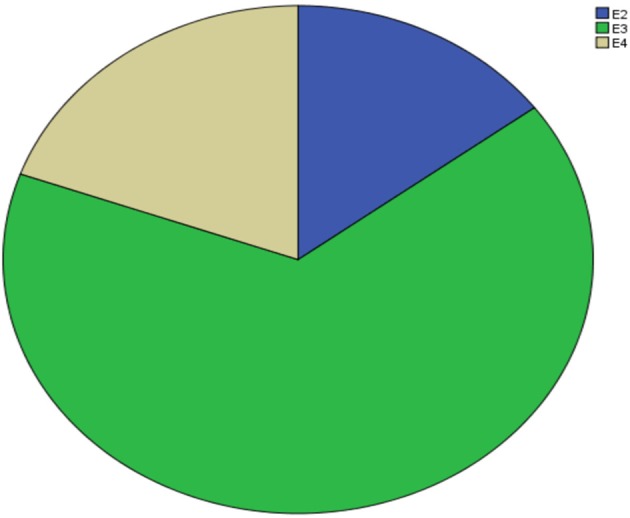
Prevalence of APOE.